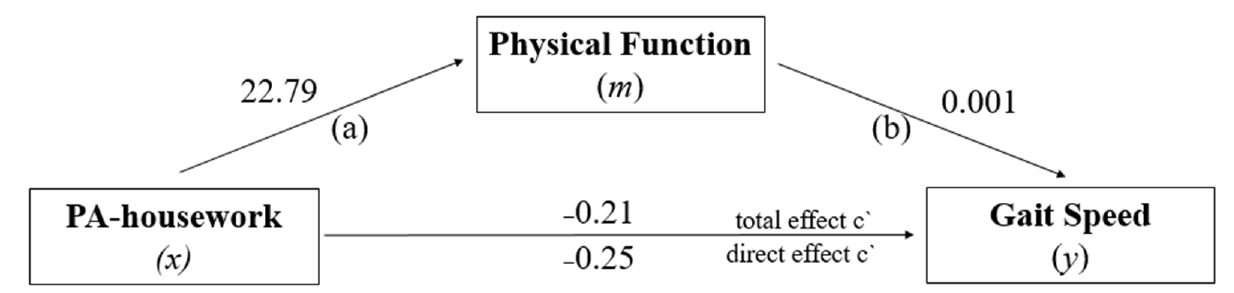
Figure 4. PF model as a mediator of the effect of PA-housework on GS.